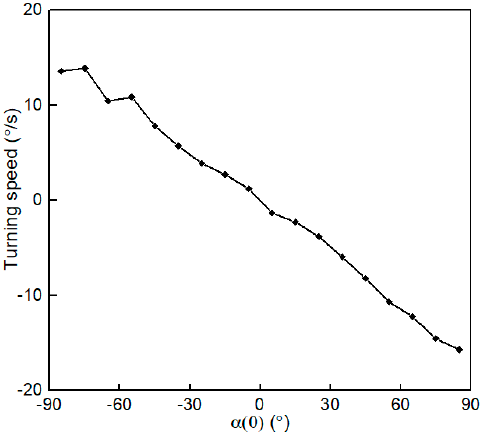
Figure 14. Turning speed of cells at different initial swimming angles.